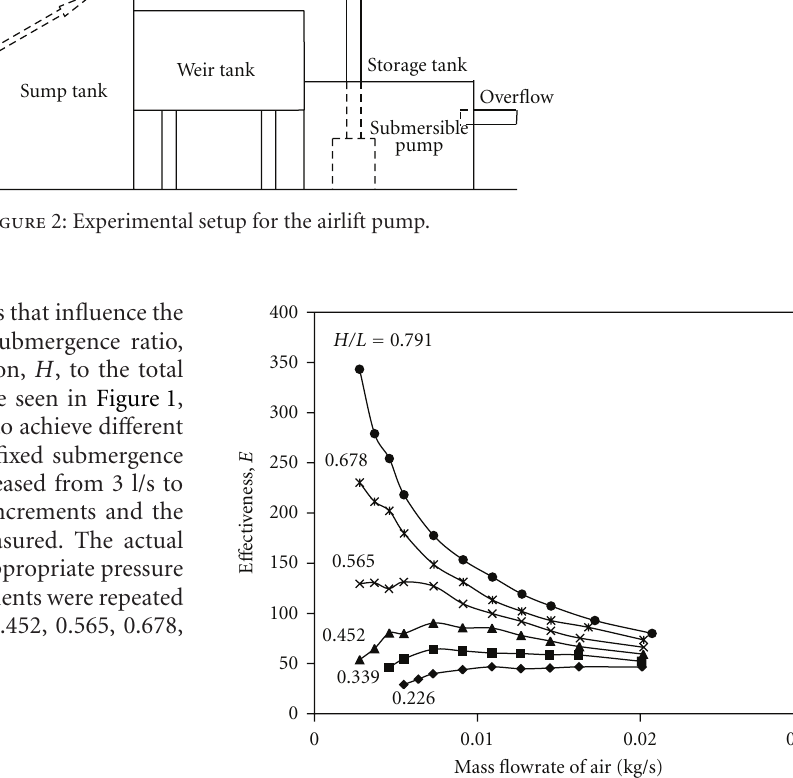
Figure 3: E ff ectiveness, E , as a function of the mass flowrate of air supplied at various submergence